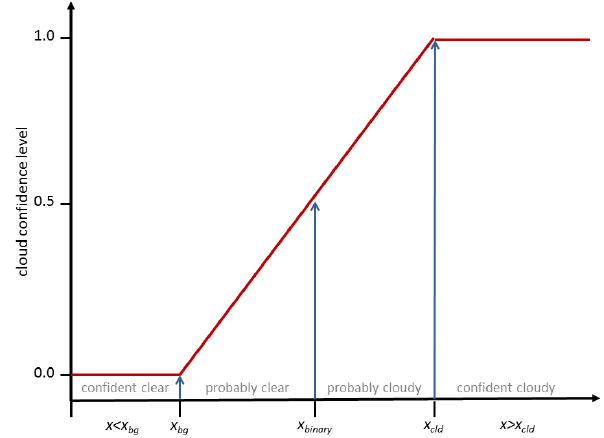
Figure 1. The linear approach of different confidence levels and thresholds used for the cloud probability estimation from an obser- vation of variable x